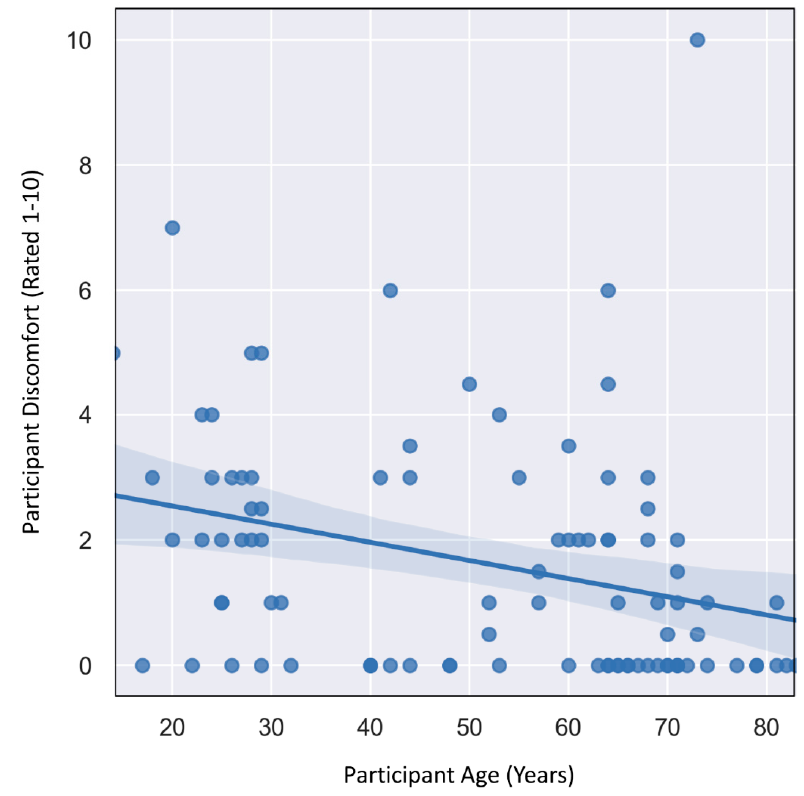
Figure 2. Plot showing patient discomfort regressed on age (R 2 = − 0.3). Table 1. Discomfort values by procedure type.